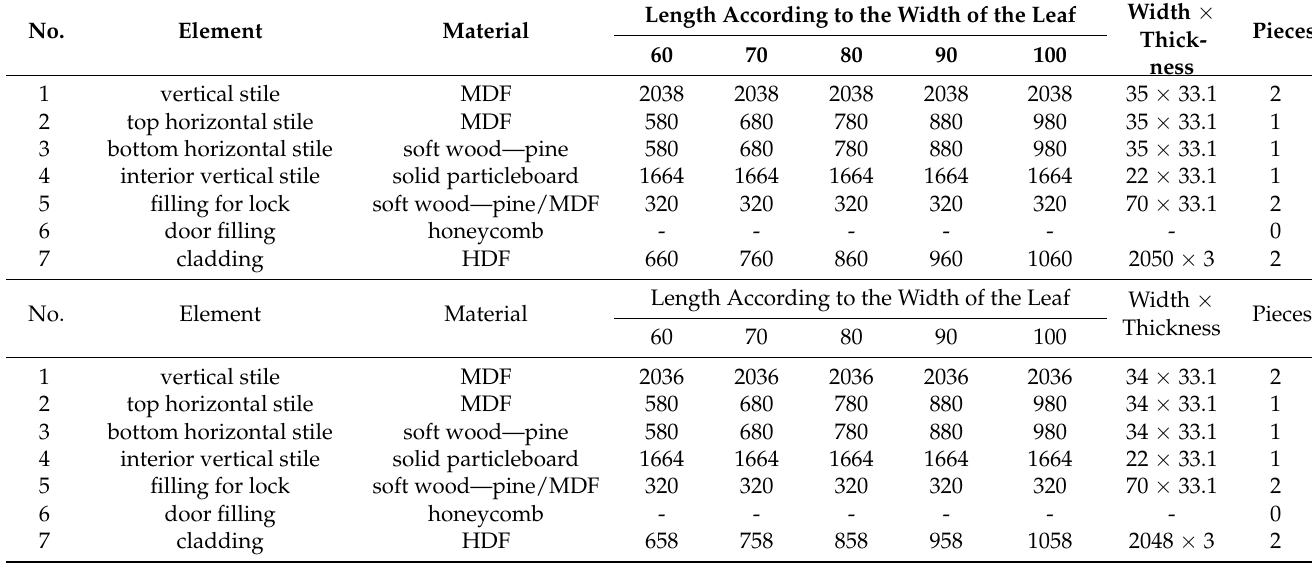
Table 3. Construction 3. Previously used values of machining allowances; reduced machining allowances, variant 1.